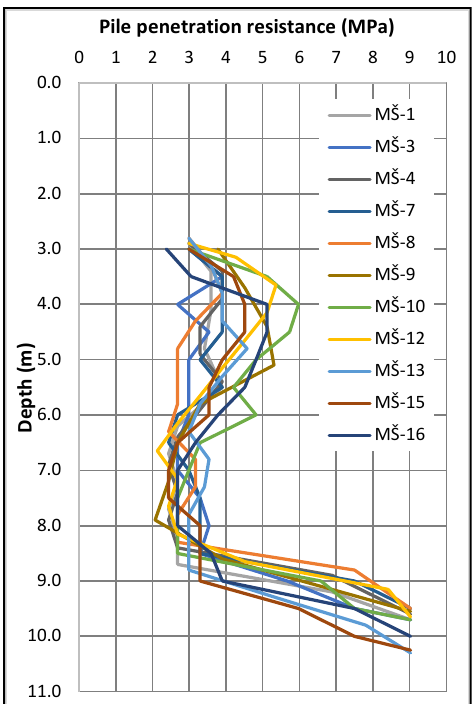
Figure 21. Measured resistances on the hydraulic jacks when pressing